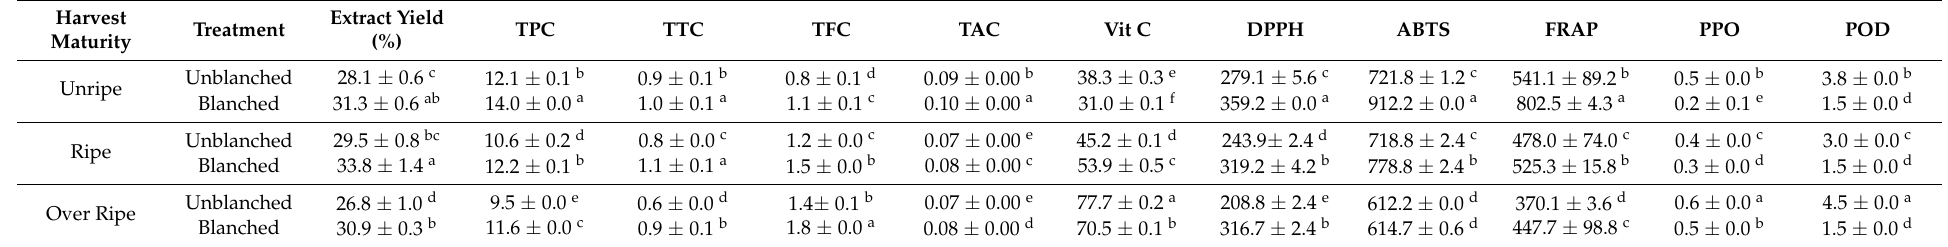
Table 1. Extraction yield, bioactive compounds, enzyme activity and antioxidant activity of ethanol (70% ( v / v )) extracts from three harvest maturities (unripe, ripe, and over ripe) of ‘Wonderful’ pomegranate peel blanched (80 ◦ C for 3